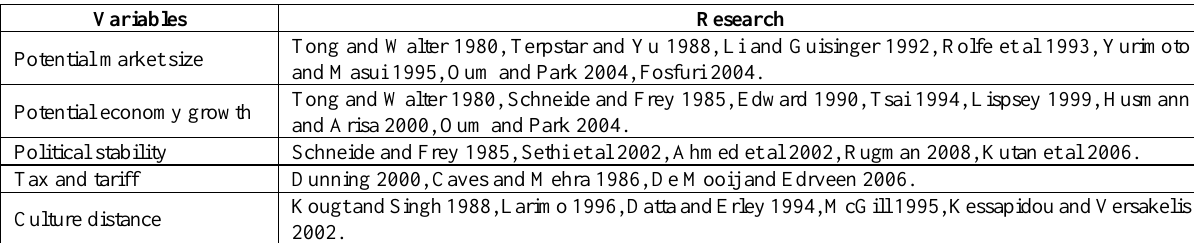
Table 2. Variables Groups